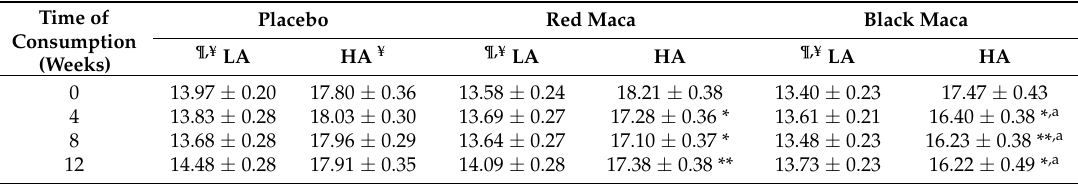
Table 4. Hemoglobin concentration (g/dL) in adult human subjects who consumed maca or a placebo at low altitude (LA) and high altitude